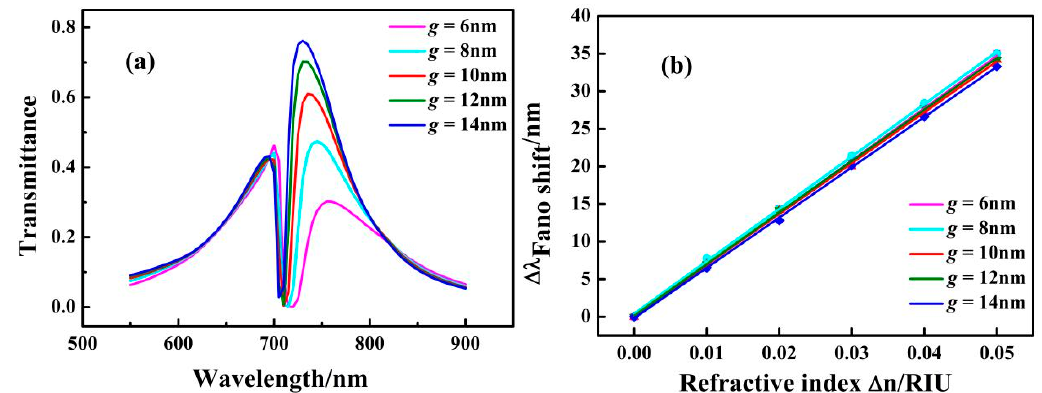
Figure 6. ( a ) Transmission spectrum for different versus of the coupling distance g ; ( b ) Fitting curve of Fano resonance peak shift caused by the refractive index change of ∆ n with different values of g .